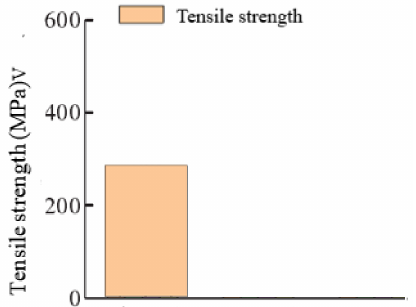
Figure 1. Tensile strength of deposited samples [16].